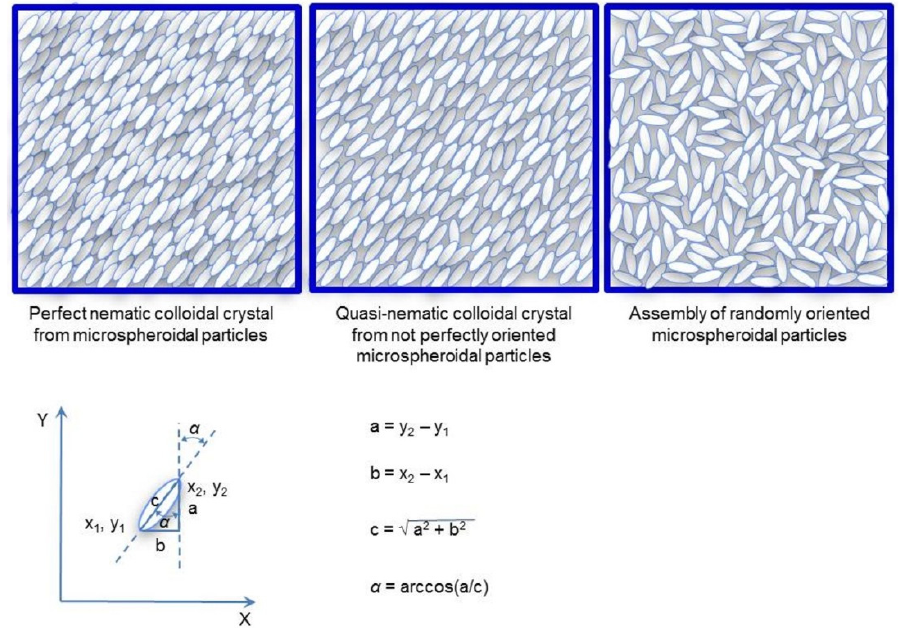
Figure 4. Schematic illustration of perfect nematic, quasi-nematic colloidal crystals, and assembly of randomly oriented microspheroidal particles and equations for calculation of α using coordinates of particle tips.